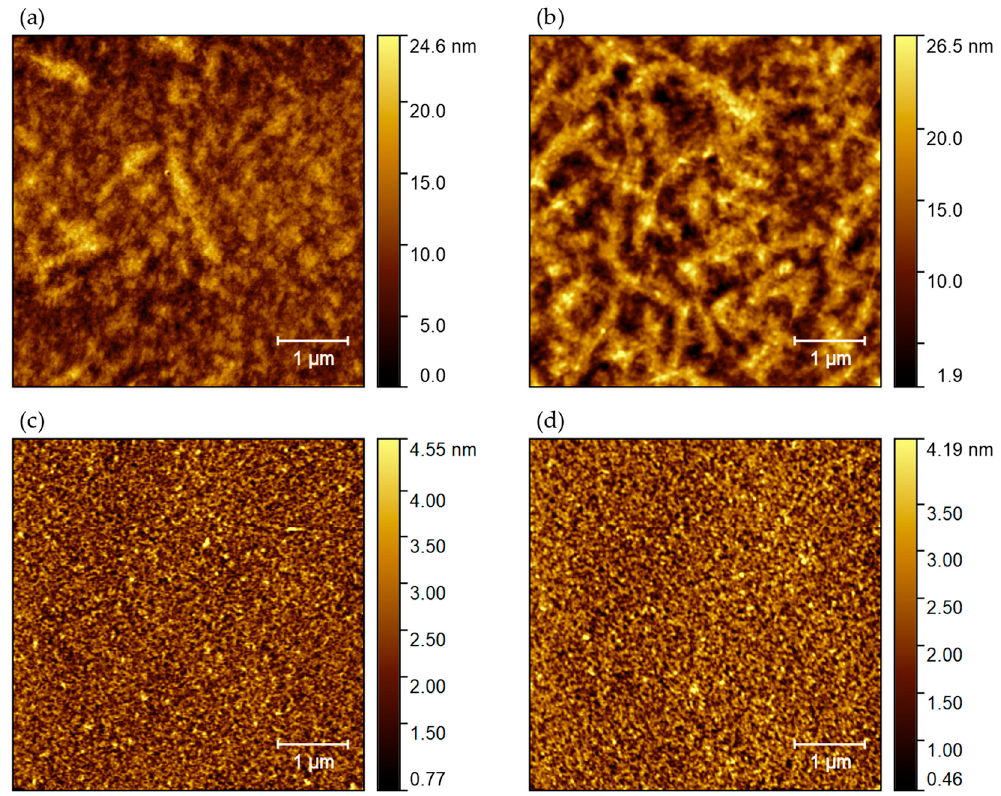
Figure 1. AFM topography maps acquired in tapping mode of P3HT deposited on Si/SiO 2 substrate ( a ) from toluene solution without adhesion promoter, ( b ) from toluene solution with Ti prime, ( c ) from oDCB solution without adhesion promoter, and ( d ) from oDCB solution with Ti prime.